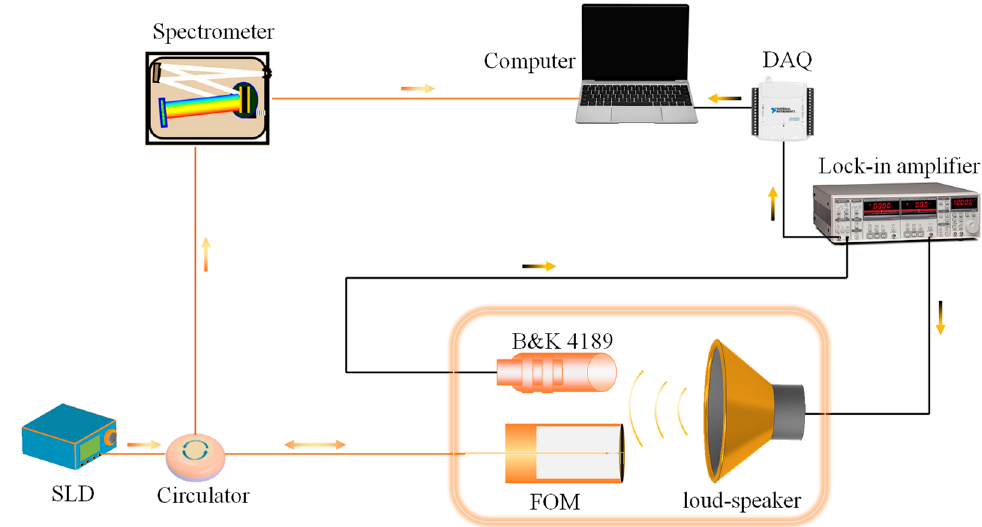
Figure 4. The principle diagram of the experimental setup for the designed FOM.